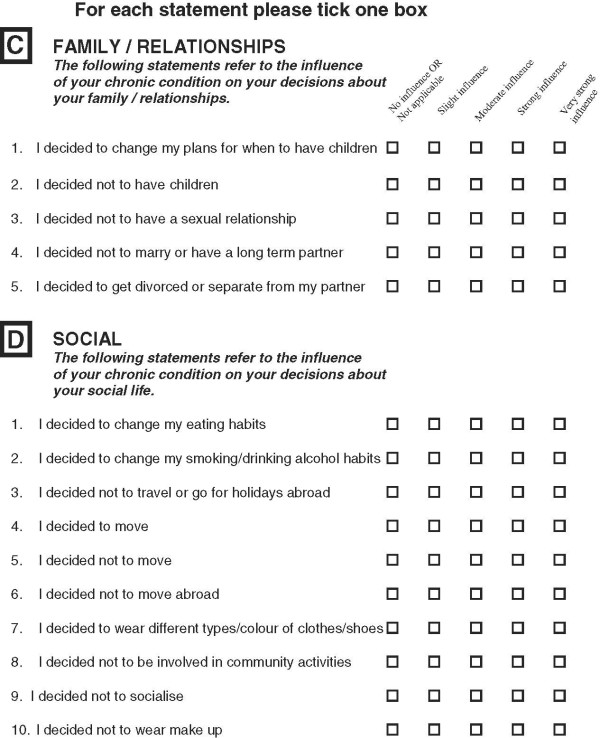
The 32-items MLCDP Part 2.